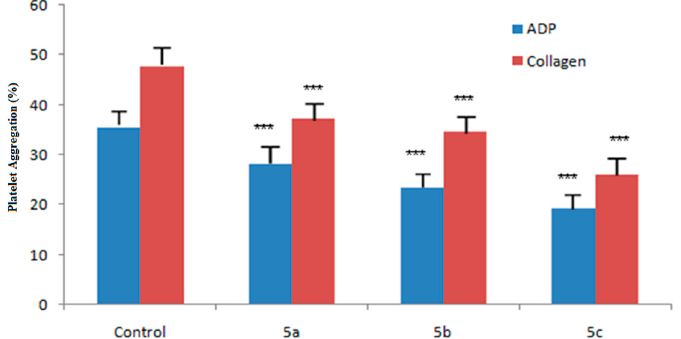
Figure 3. Antiplatelet aggregation activity of synthesized prodrugs ( 5a – c ) in rats administered orally. The platelet rich plasma was obtained from the blood 90 min after prodrugs (100 mg/kg) were orally administered into Sprague-Dawley (SD) rats, and platelet aggregation was induced by adenosinediphosphate (ADP) (1.3 µmol/L) or collagen (32.8 µg/mL), Significant at *** = p < 0.001.